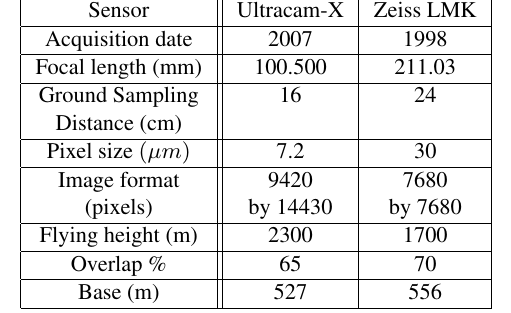
Table 3: Characteristics of photogrammetric datasets.